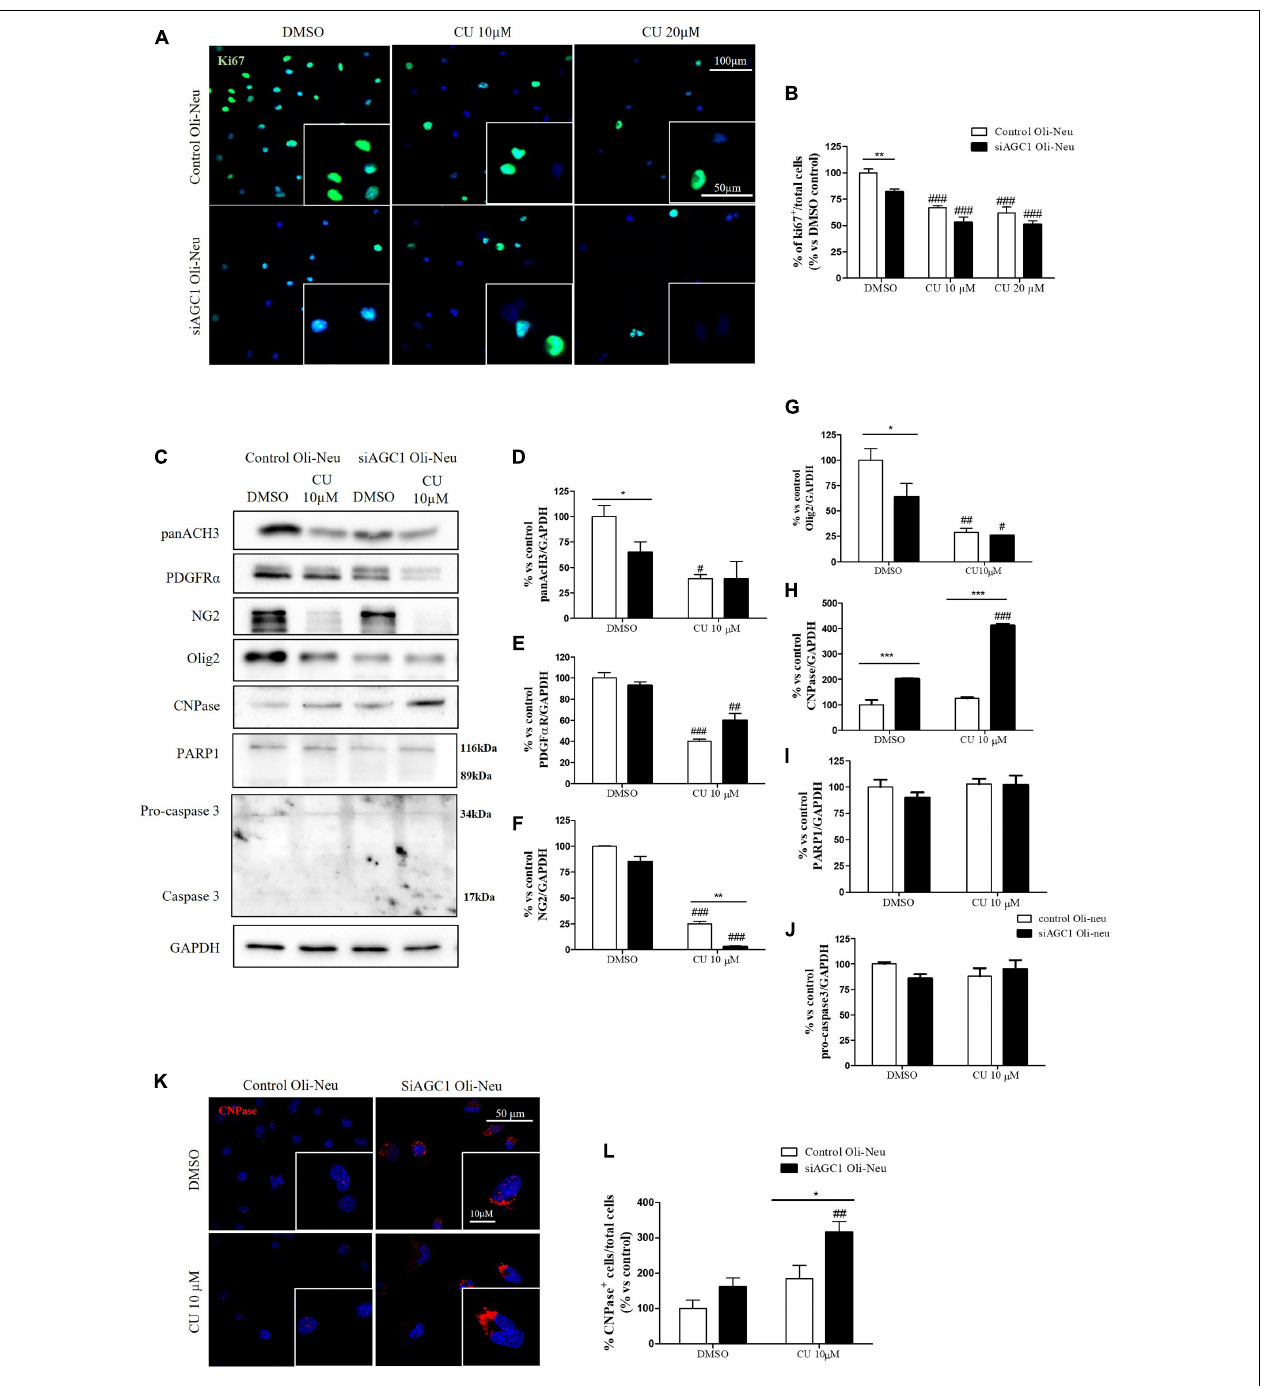
FIGURE 6 | Curcumin-mediated HAT inhibition differentially affects proliferation in both control and siAGC1 Oli-Neu cells. Immunofluorescence staining of Ki67 proliferation marker (A) and Ki67 + cell count analysis (B) in Oli-Neu cells after 24 h treatment with 10 or 20 µ M curcumin. Values are expressed as the ratio of Ki67 + cells (green)/total cells; nuclei were labeled with DAPI. Values are mean ± SD of 3 independent experiments; 3 different fields were acquired for each condition. 40X objective; 50 and 100 µ m bar scale. WB and relative densitometries of panAcH3 (C,D) , PDGFR α (C,E) , NG2 (C,F) , Olig2 (C,G) , CNPase (C,H) , PARP1 (C,I) , and pro-caspase3 (C,J) expression in OliNeu cells after 48 h treatment with 10 µ M curcumin. Immunofluorescence staining of CNPase (K) and CNPase + cell count analysis (L) in Oli-Neu cells after 48 h treatment with 10 µ M curcumin. Values are expressed as the ratio of CNPase + cells (red)/total cells; nuclei were labeled with DAPI. Three different fields were acquired for each condition. Values are mean ± D of at least 3 independent experiments. 40X objective; 50 and 10 µ m bar scale. # p < 0.05, ## p < 0.01, ### p < 0.001, compared to DMSO control, respectively; * p < 0.05, ** p < 0.01, *** p < 0.001, compared to each treated control; two-way ANOVA (Bonferroni’s post hoc